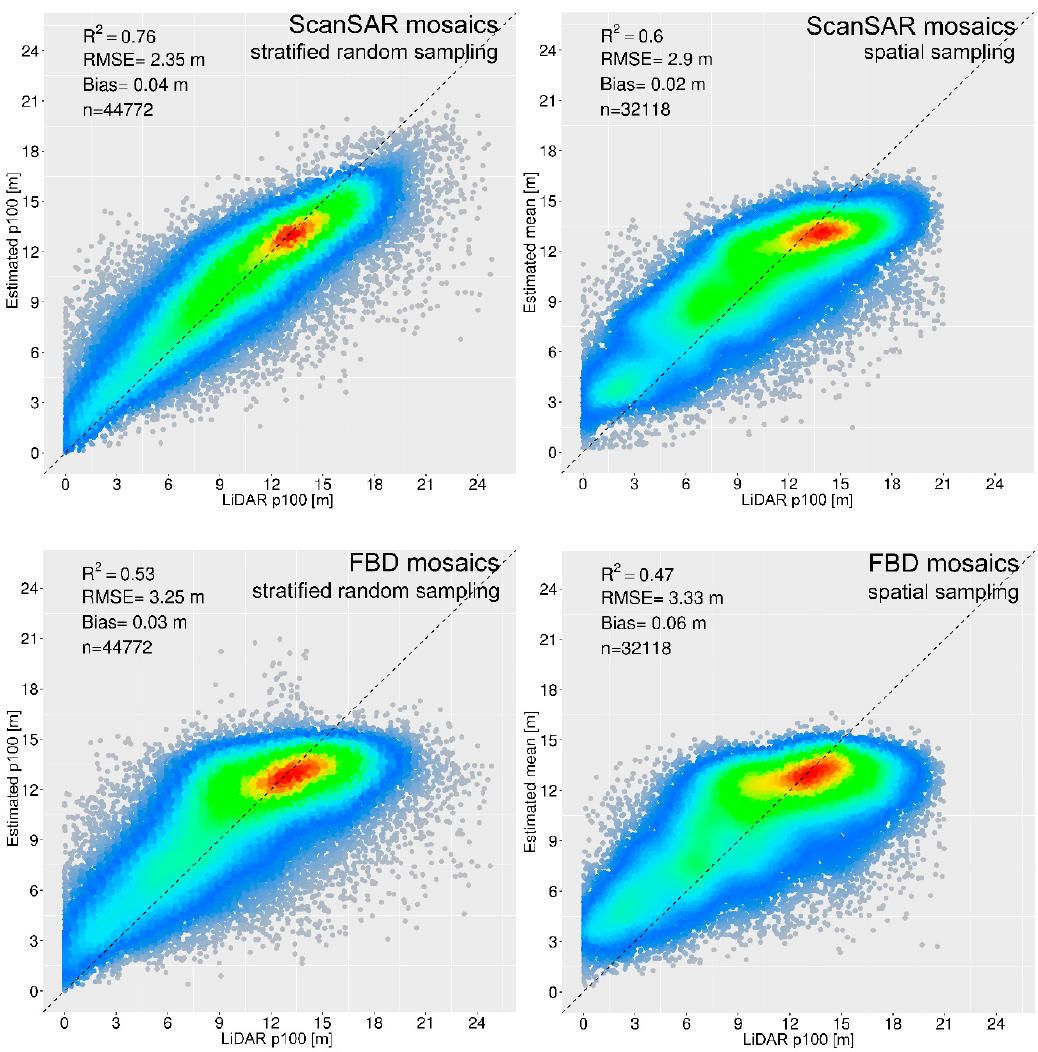
Figure 6. ScanSAR ( above ) and FBD ( bottom )-based vegetation height estimates plotted against LiDAR p100 metric. The training and test data were split using “stratified random sampling” ( left ) and “spatial sampling” ( right ). ScanSAR mosaics (24 scenes) show higher retrieval accuracy compared to FBD mosaics (3 scenes) due to a larger number of SAR images. The “stratified random sampling” approach shows higher goodness-of-fit statistics compared to the “spatial sampling” approach due to spatial autocorrelation between training and test data.